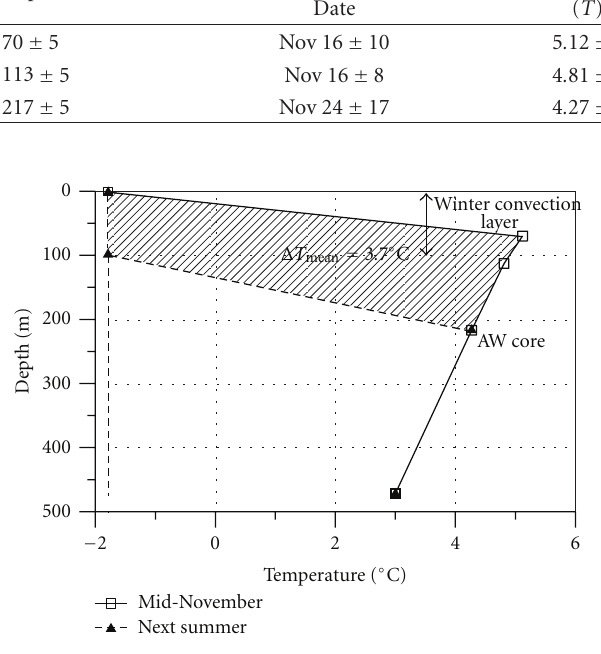
Figure 3: Sketch of the upper FSBW transformation during the winter season.